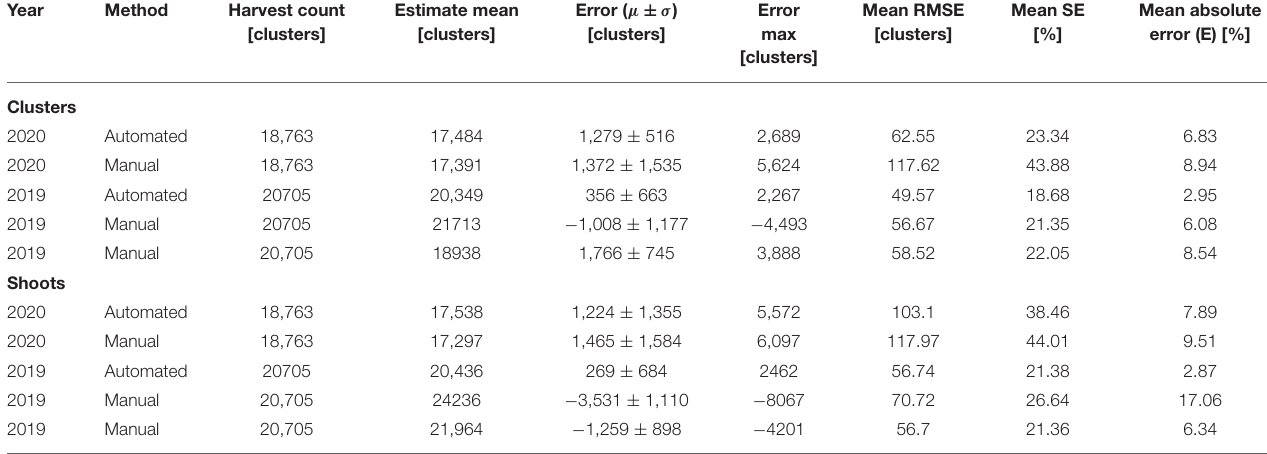
RMSE is calculated by equation (1), SE by equation (2), and absolute error by equation